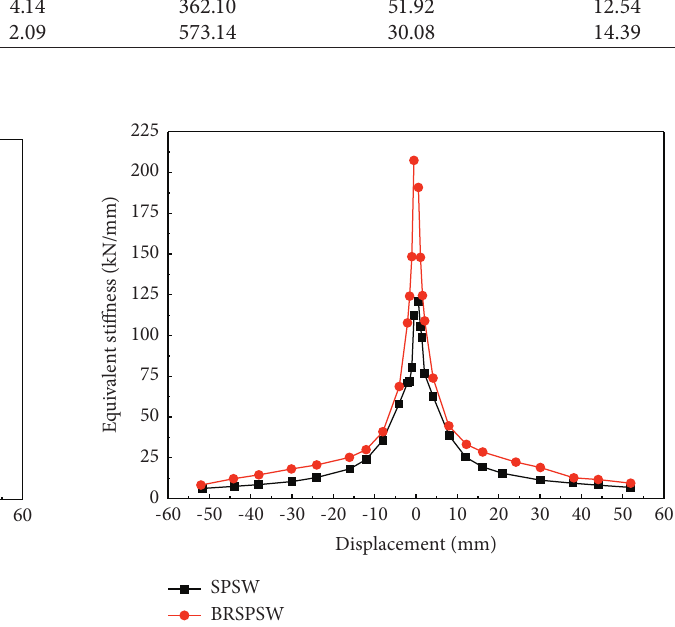
Figure 16: Skeleton curves of both specimens. Figure 17: Equivalent stiffness curves of both